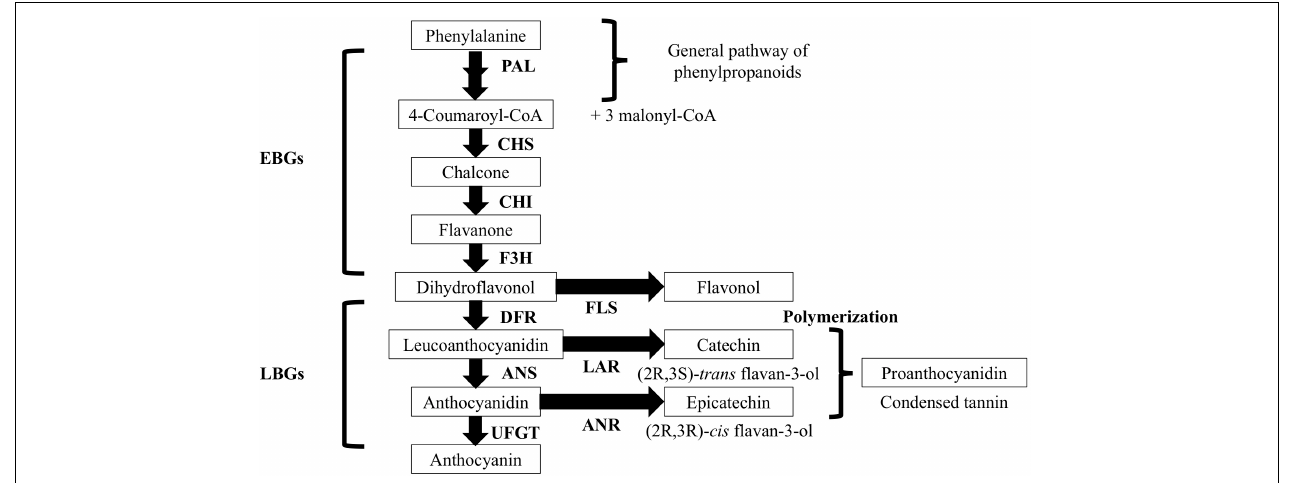
FIGURE 1 | General diagram of the biosynthetic pathway of flavonoids in Prunus salicina Lindl. EBGs, early biosynthetic genes; LGBs, late biosynthetic genes; PAL, phenylalanine ammonia-lyase; CHS, chalcone synthase; CHI, chalcone isomerase; F3H, flavanone 3-hydroxylase; DFR, dihydroflavonol reductase; LAR, leucoanthocyanidin reductase; ANS, anthocyanidin synthase; ANR, anthocyanidin reductase; UFGT, UDP-flavonoid 3- O -glucosyltransferase; FLS, flavonol synthase. Modified from Dixon et al.